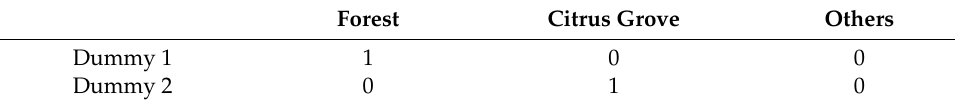
Table A1. Rule of dummy variables on land use.